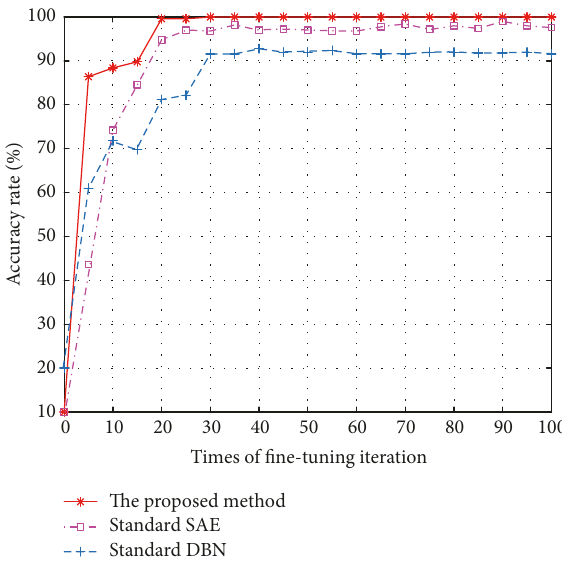
Figure 10: Curves of the accuracy and fine-tuning iteration of the proposed method, standard SAE, and standard